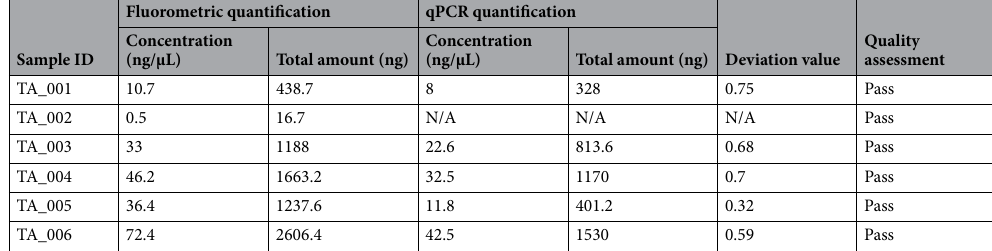
Table 2. Quality assessment of divided samples for gene panel testing (Oncomine Comprehensive Assay v3). qPCR = quantitative polymerase chain reaction.